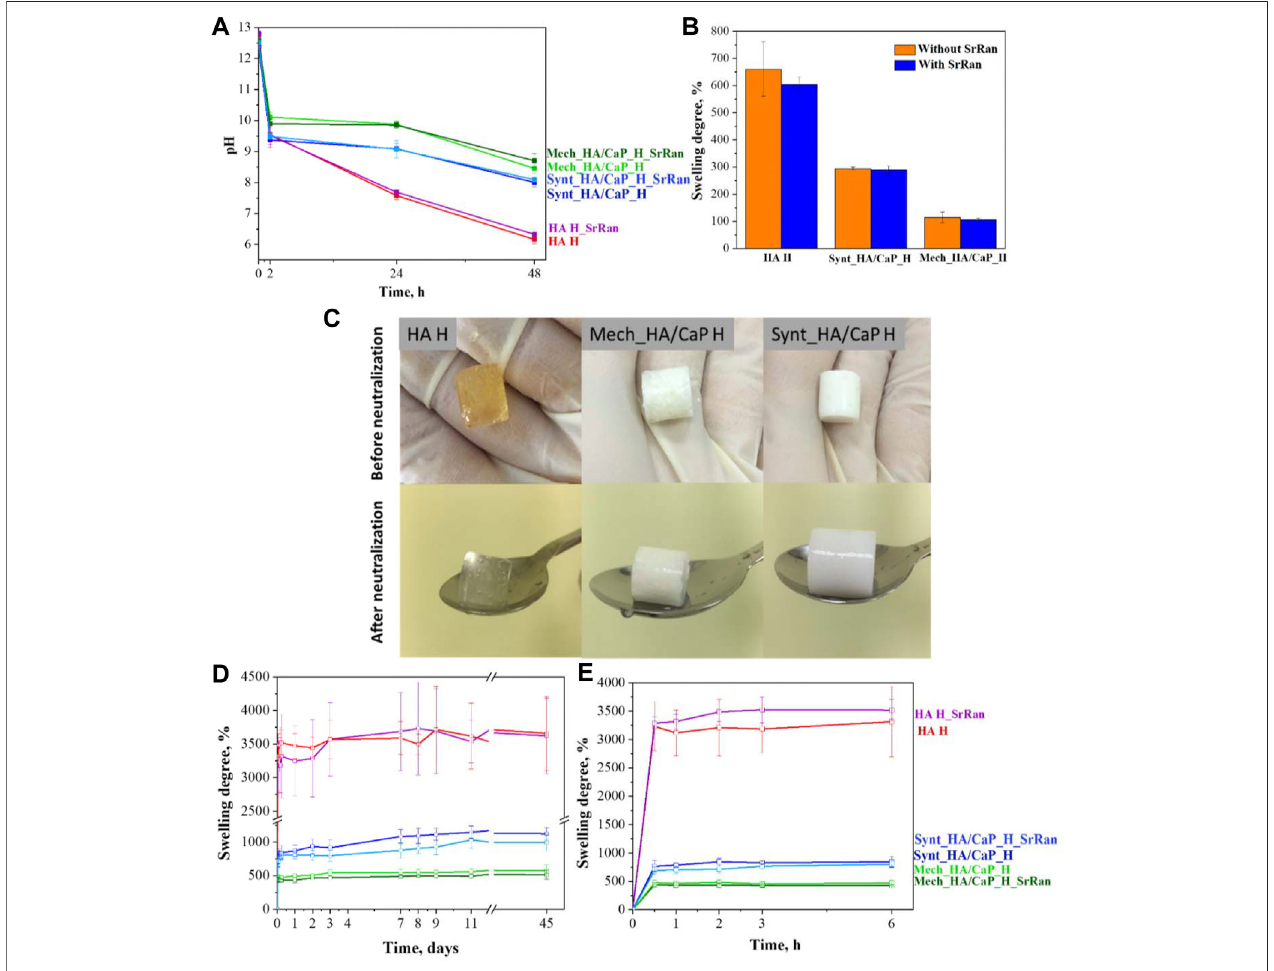
FIGURE 7 | Neutralization process and swelling degree of hyaluronic acid-containing hydrogels. (A) pH change of HA-containing hydrogels during neutralization; (B) swelling ratio of hydrogels during neutralization; (C) HA-containing hydrogels before and after neutralization; (D) swelling behavior of HA-containing lyophilized hydrogels for 45 days; (E) swelling behavior of HA-containing lyophilized hydrogels in the fi rst 6 h.